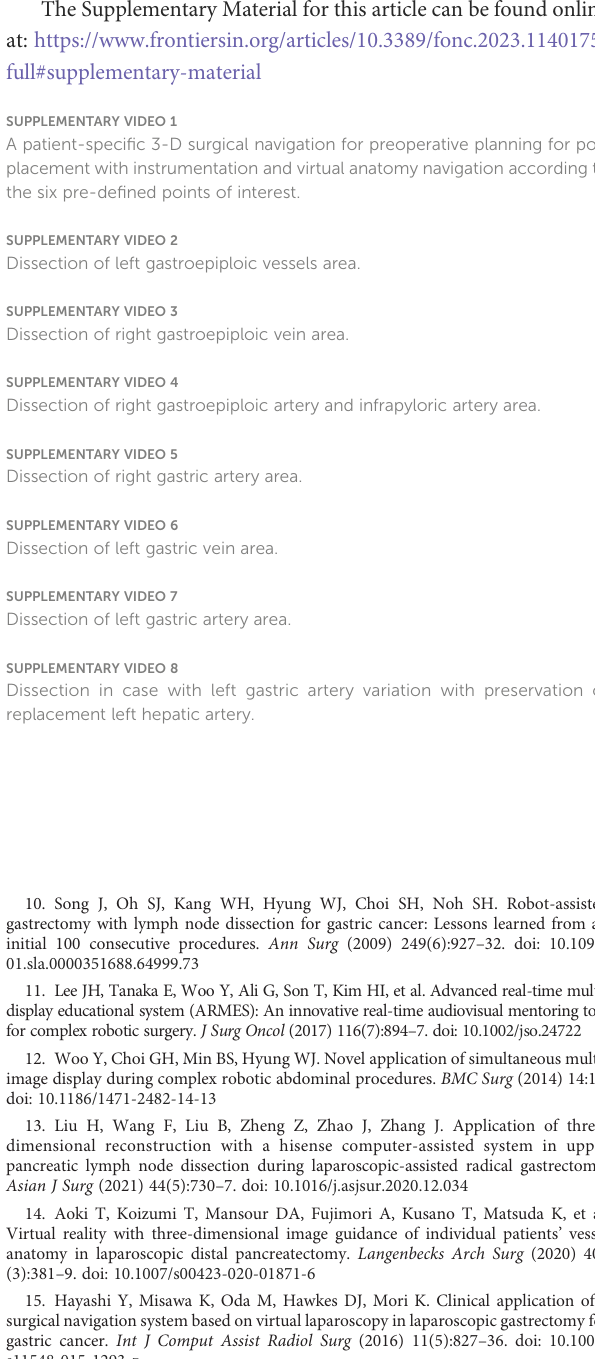
SUPPLEMENTARY VIDEO 2 Dissection of left gastroepiploic vessels area. SUPPLEMENTARY VIDEO 3 Dissection of right gastroepiploic vein area.